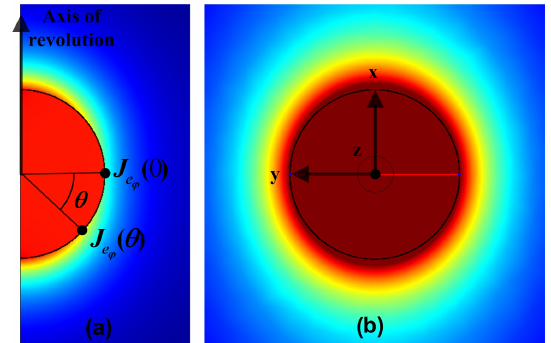
Figure 3. Magnetic field magnitude distribution of the ideal homo- geneous coil (assuming cos( θ ) distribution of the current density along the circumference) performed on a numerical finite-element software: (a) case of a solid of revolution and (b) case of a 2-D plane infinite (along z ) geometry. The colour scale is related to the magnitude of the magnetic field. The homogeneity of the colour is related to the homogeneity of the magnetic field.